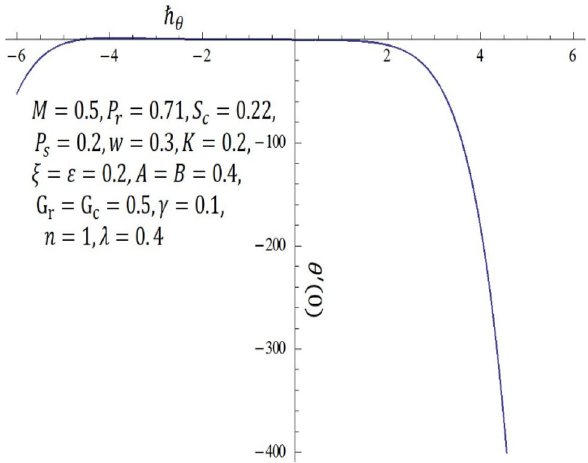
Figure 17. ℏ -curve of θ ′ ( 0 ) obtained at 10th -order of approximation.